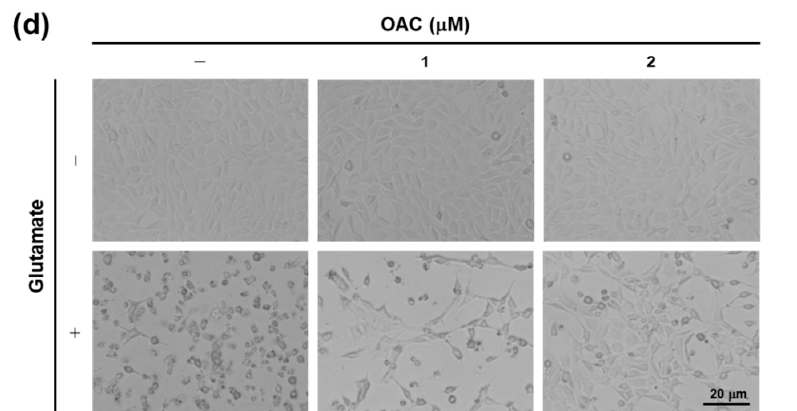
Figure 1. Neuroprotective effect of OAC against glutamate-induced HT22 hippocampal cell death. ( a ) The chemical structure of OAC. ( b ) Cell viability recovered by treatment with OAC in a dose- dependent manner. ( c ) N-acetylcysteine, used as a reference drug, prevented glutamate-induced HT22 cell death. ( d ) Cell morphology changes after 24 h of treatment with OAC at the concentration of 1 and 2 μ M, in the presence or absence of 5 mM glutamate. OAC: osmundacetone; NAC: N- acetylcysteine; ∗ p < 0.001 vs. glutamate-treated group; # p < 0.001 vs. non-treated group.